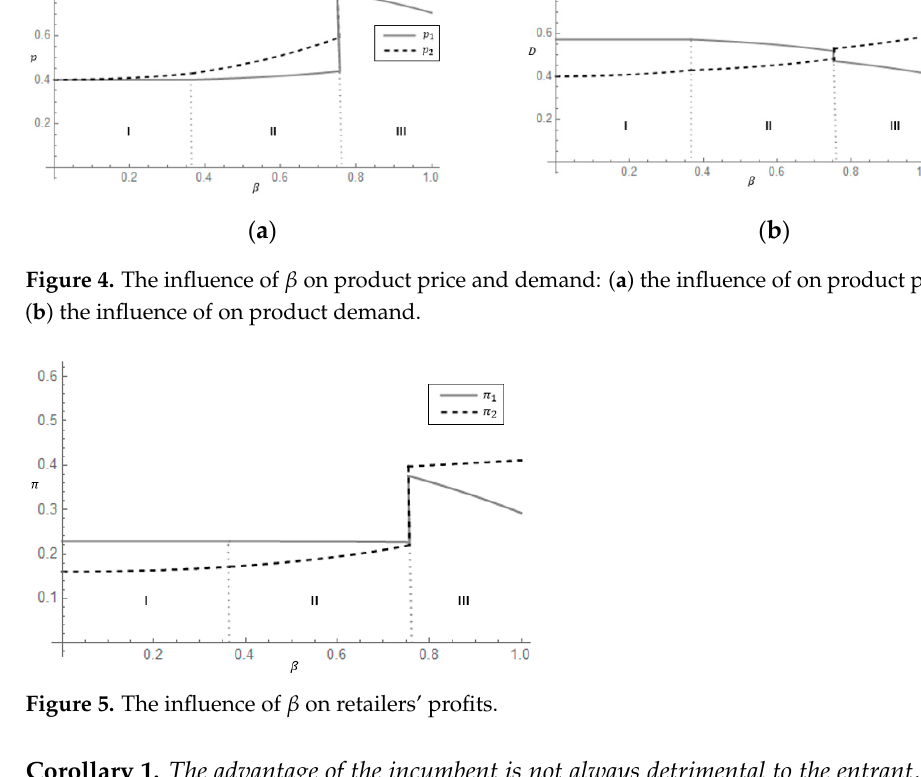
Figure 5. The influence of β on retailers’